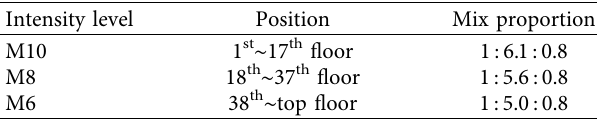
Table 3: Microconcrete mix